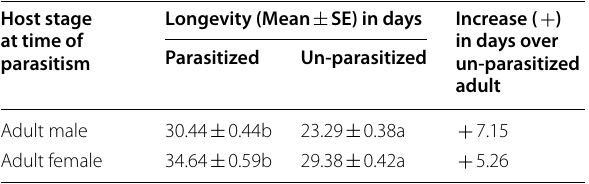
Table 2 Effect of parasitism by F. melanoleuca on the longevity of P. perpusilla adults